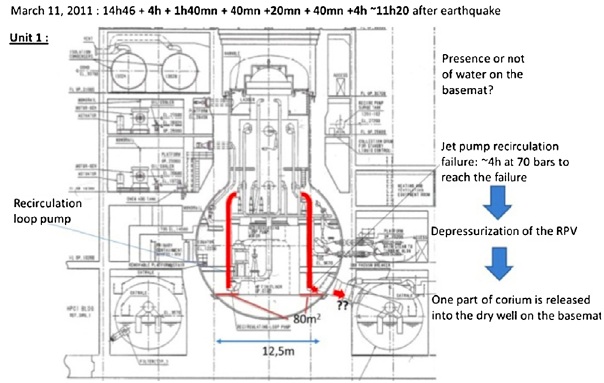
Fig. 9. Illustration of the jet pump recirculation failure from liquid corium settled inside: ∼ 11 h 20 after the reactor shutdown.